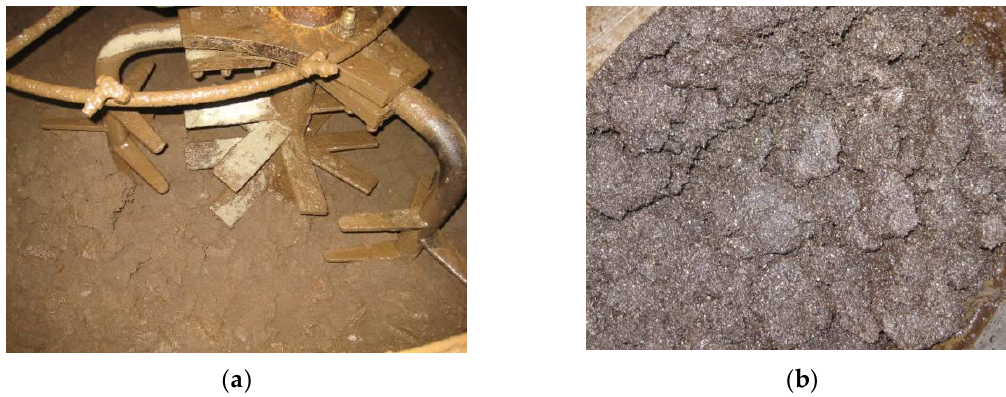
Figure 1. Flocculation and demulsification of emulsified asphalt in CAM I ( a ) Unable to mix, ( b ) Flocculation.